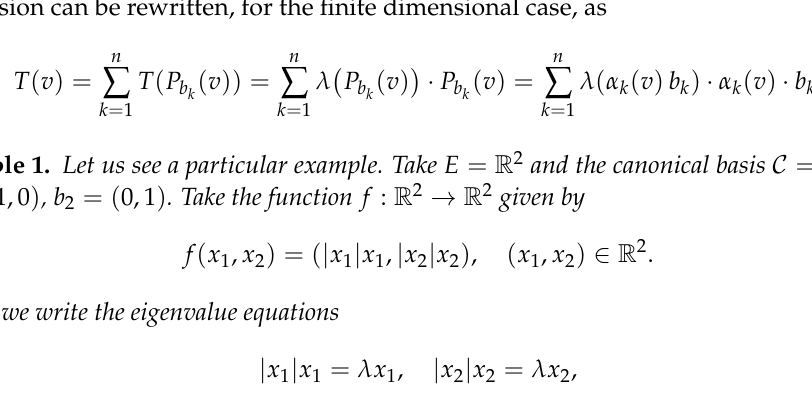
| x | . Figure 1 provides a representation of the eigenvectors of T.